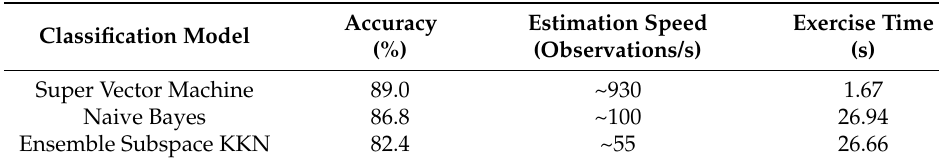
Table 4. Comparative analysis of training results.